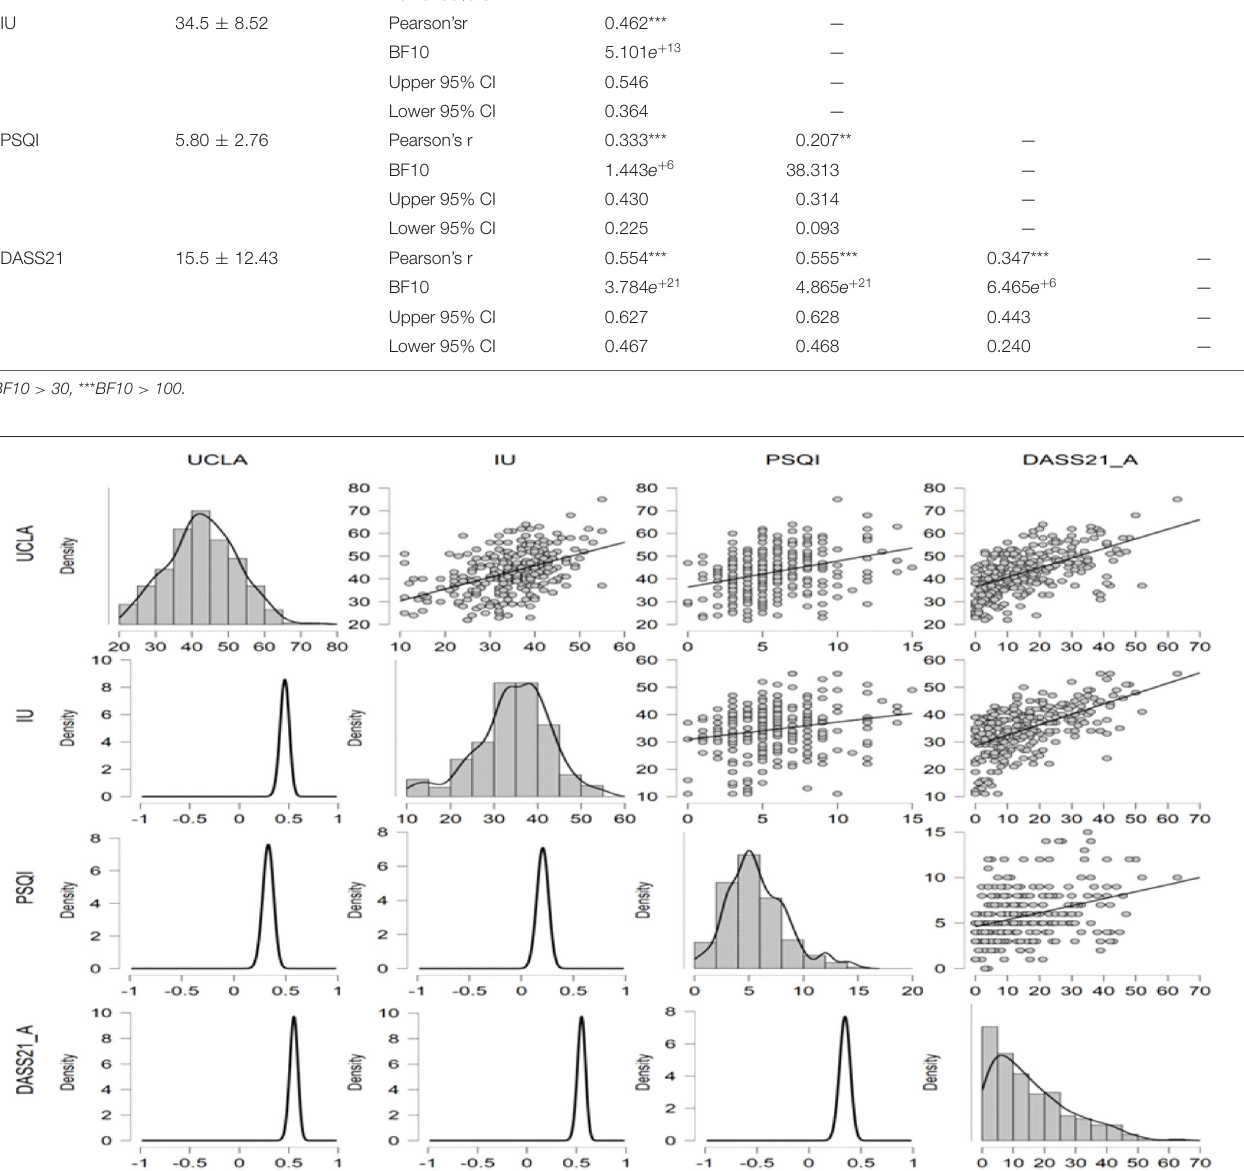
likely to be biased and yield a far worse fit than their population values (33, 34). Our sample size is < 500, belonging to small samples, which may be the main reason for the inconsistency of evaluation